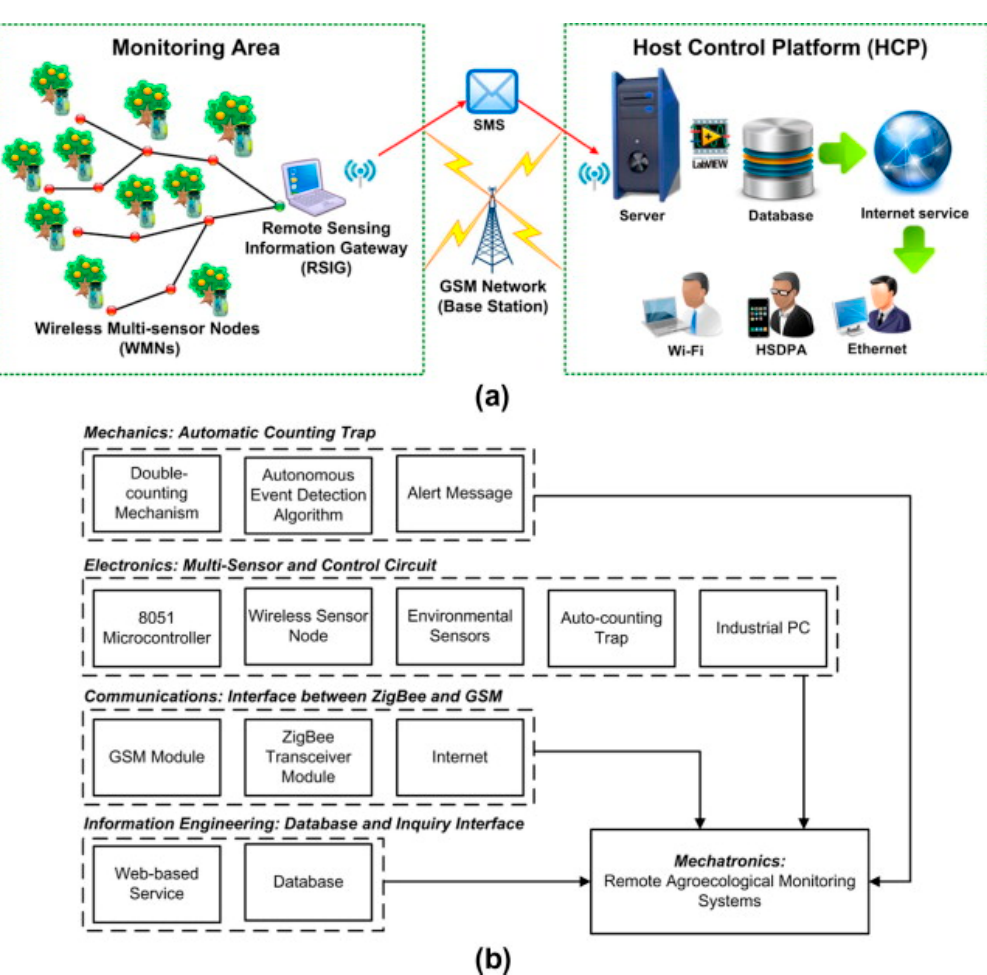
Figure 4. Monitoring system proposed by Liao et al. [54]. Overall conceptual model of the system ( a ). Block diagram integrating technologies in the remote agroecological monitoring system ( b ). HSDPA: High Speed Downlink Packet Access. PC: GSM.